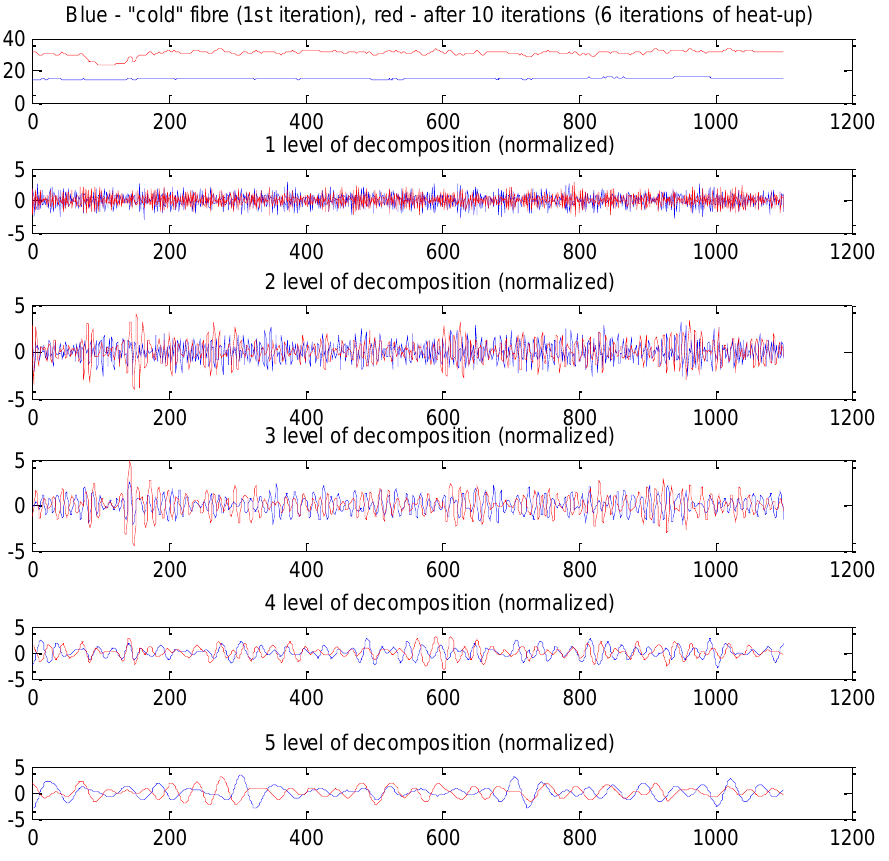
Figure 18. Results of MODWT application: X axis—length of the cable (m), Y axis—temperature (Celsius).